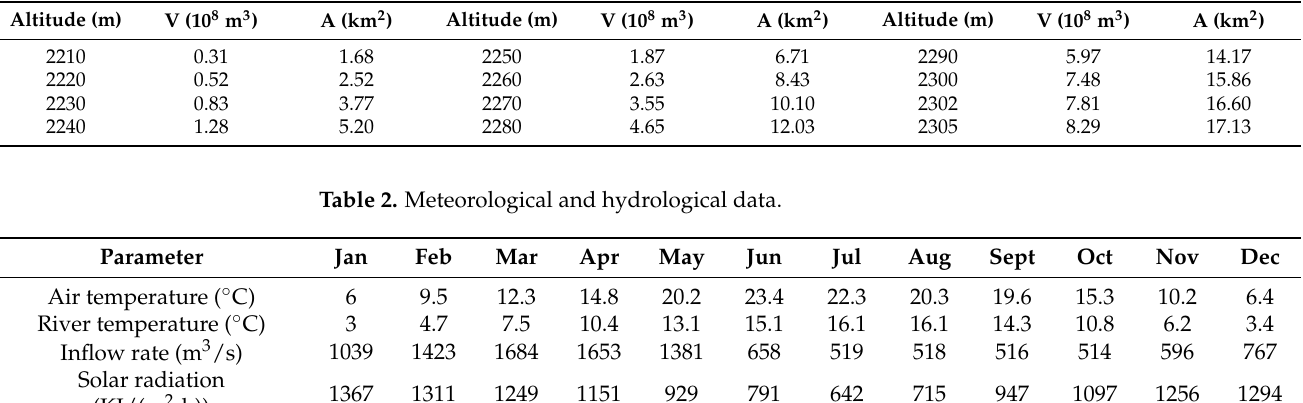
( d ) Figure 4. Temperature at different depths of Xulong. ( a ) Water depth 20 m. ( b ) Water depth 40 m. ( c ) Water depth 100 m. ( d ) Bottom of reservoir. Figure 4 shows the temperature duration curves of several typical water depths. It can be seen from the figure that the model fits well for the water temperature of different